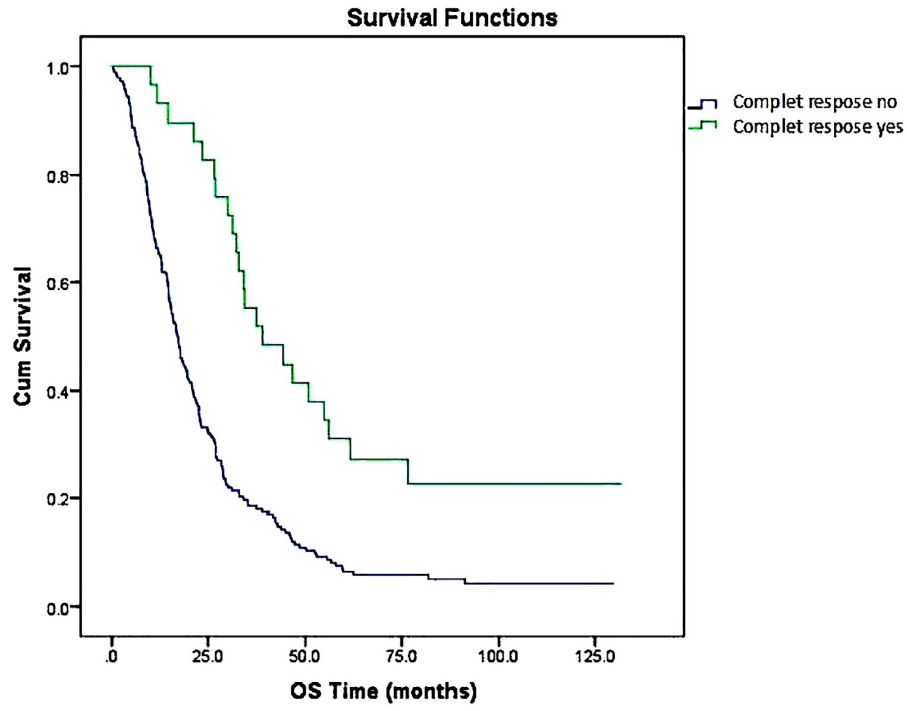
Fig 1. Overall survival analysis based on whether a complete response was attained.